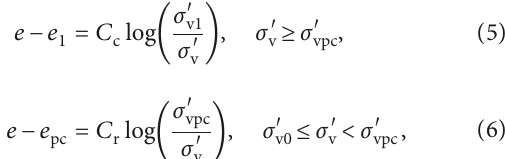
of overconsolidated v ′